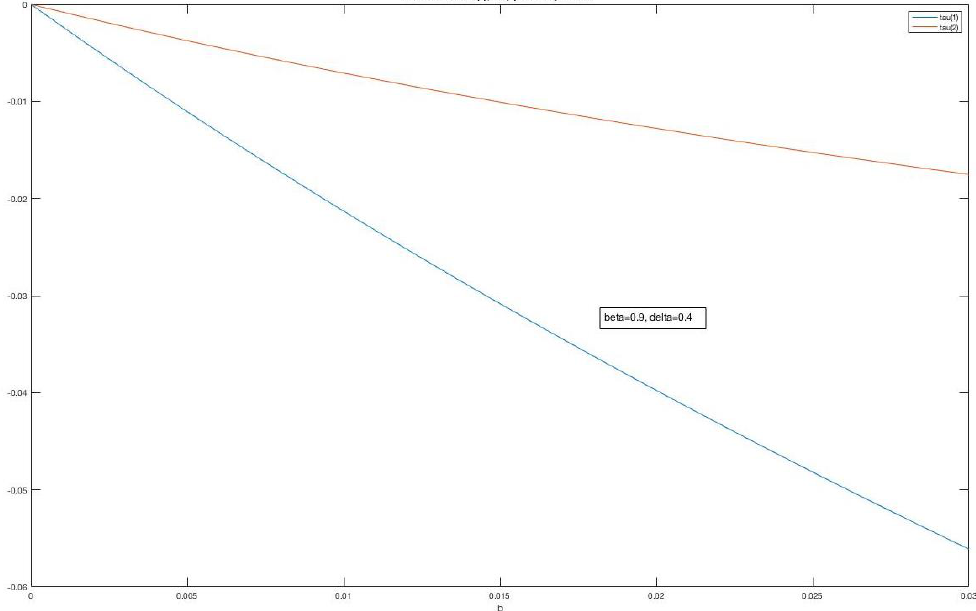
and τ 1 , where tau(1) and tau(2) denote, respectively, τ 1 2 1